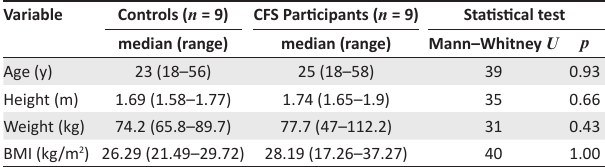
TABLE 2: Demographic characteristics of the participants ( N =